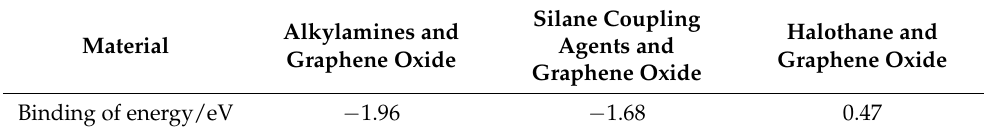
Table 1. The binding energy of different modifiers to graphene oxide.